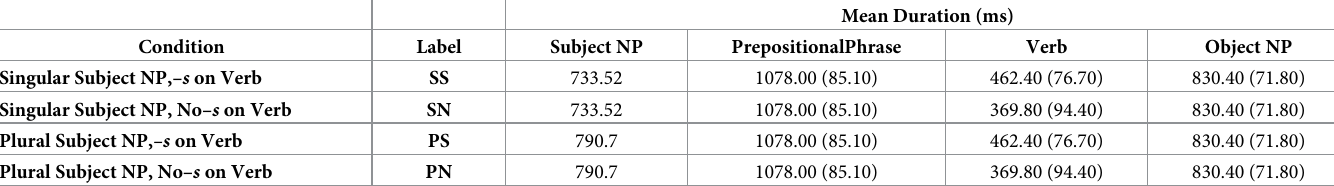
Table 3. Mean duration (ms) for each phrase of the sentences tested in the auditory ERP experiment with their SDs (in